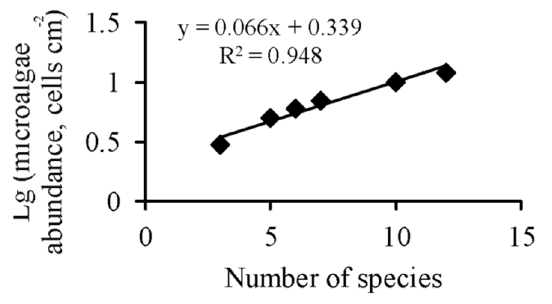
Figure 2. Dependence of the benthic microalgae abundance on the abundance of their species (Sivash Bay, June 2019).